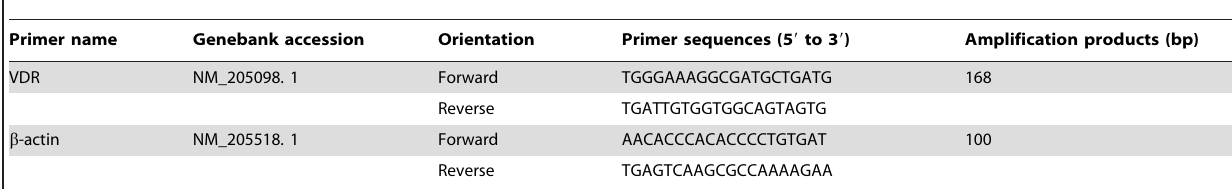
Table 2. Primers used for the determination of vitamin D receptor protein (VDR) and calcium binding protein (Calbindin).